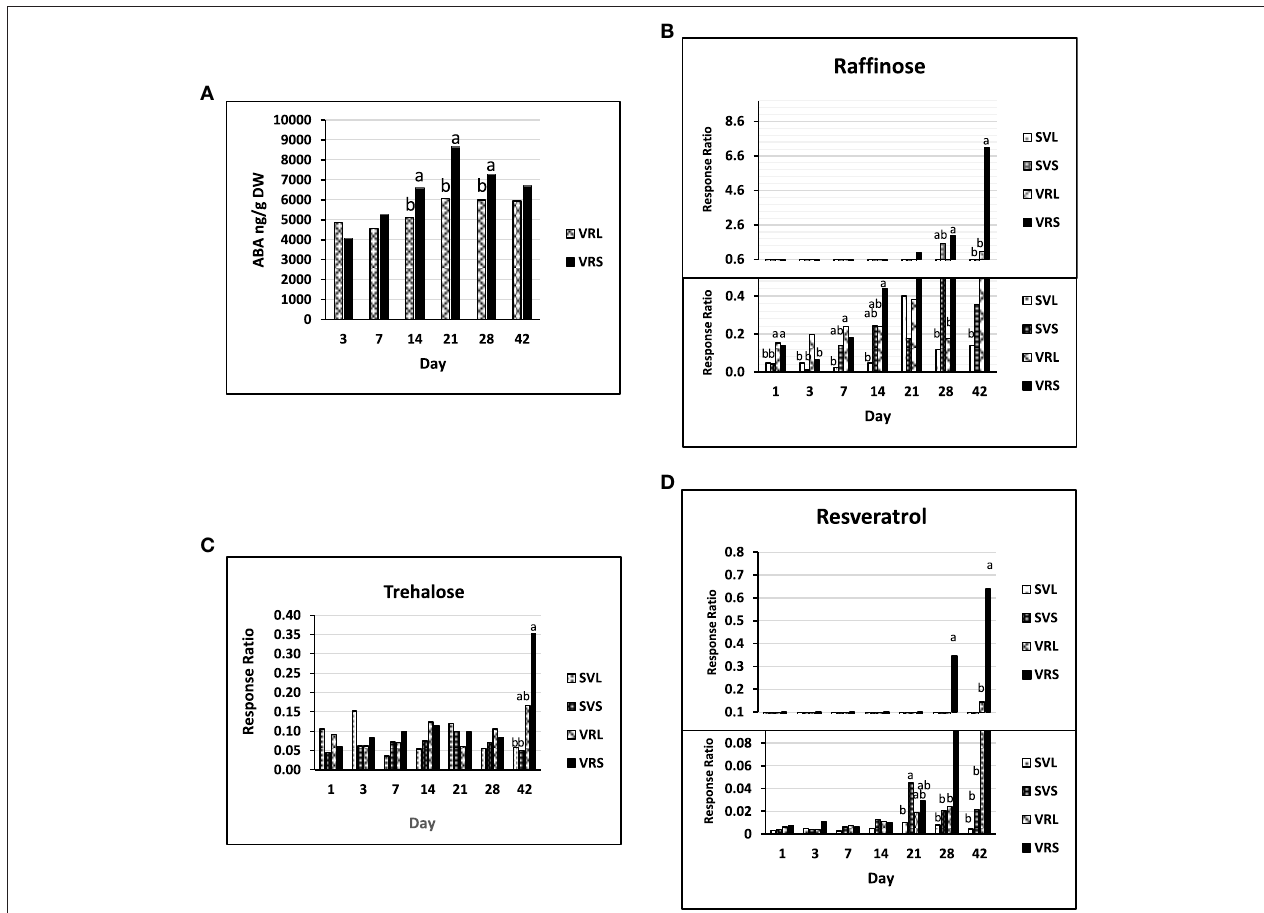
FIGURE 5 | Metabolites in V. riparia and Seyval under long or short day conditions (VRL or VRS and SVL or SVS). (A) Abscisic acid concentration in V. riparia long or short day buds (VRL or VRS, respectively). Values are ABA concentration per gram dry weight (DW) (B) Raffinose accumulation relative to ribitol in V. riparia and Seyval long or short day buds (VRL, VRS, SVL, SVS; respectively). (C) Trehalose accumulation relative to ribitol (response ratio) in VRL, VRS, SVL and SVS. (D) Resveratrol accumulation relative to ribitol (response ratio) in VRL, VRS, SVL, and SVS. Values are mean and standard error of abundance. Tukey’s HSD significant differences ( p < 0.05 , n = 5 ) between SVL, SVS, VRL, and VRS at a given time point are noted by different letters, no letter indicates no difference found at that time point.